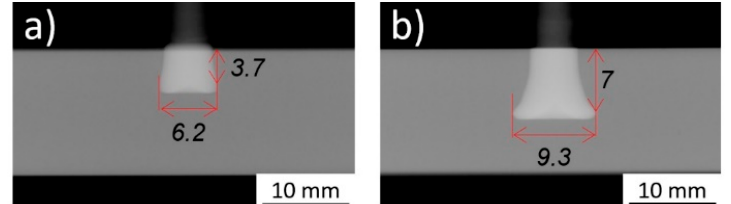
Figure 5. X-ray tomography of: ( a ) Condition 1 (E M = 24 J; RS = 18,000 rpm; FT = 1.6 s; FoT = 1 s; FF = 2000 N; FoF = 5100 N); ( b ) Condition 4 (E M = 77 J; RS = 20,000 rpm; FT = 2 s; FoT = 1 s; FF = 2000 N; FoF = 5100 N).